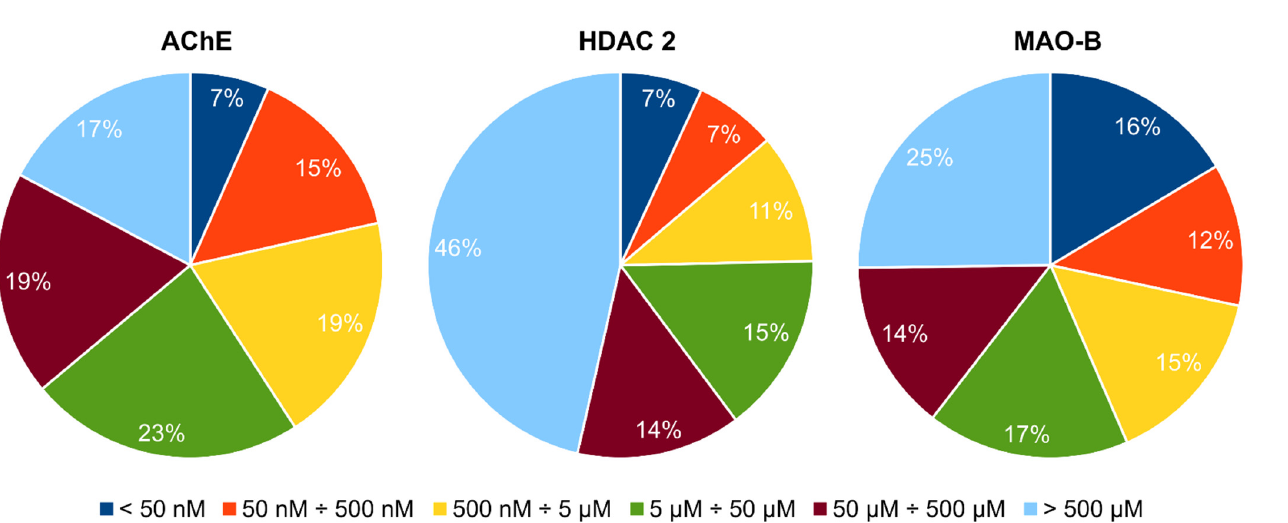
Figure 4. Distribution (in %) of the top 377 compounds based on the predicted K i values for each of the three proteins.